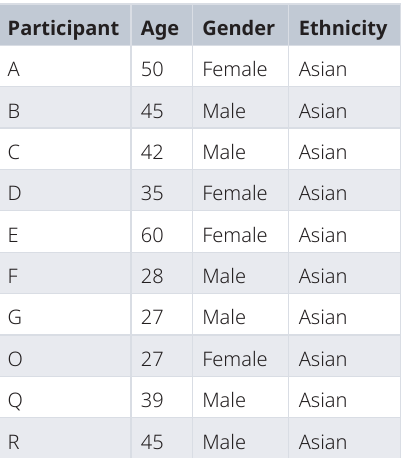
Table 1. Demographic data of the